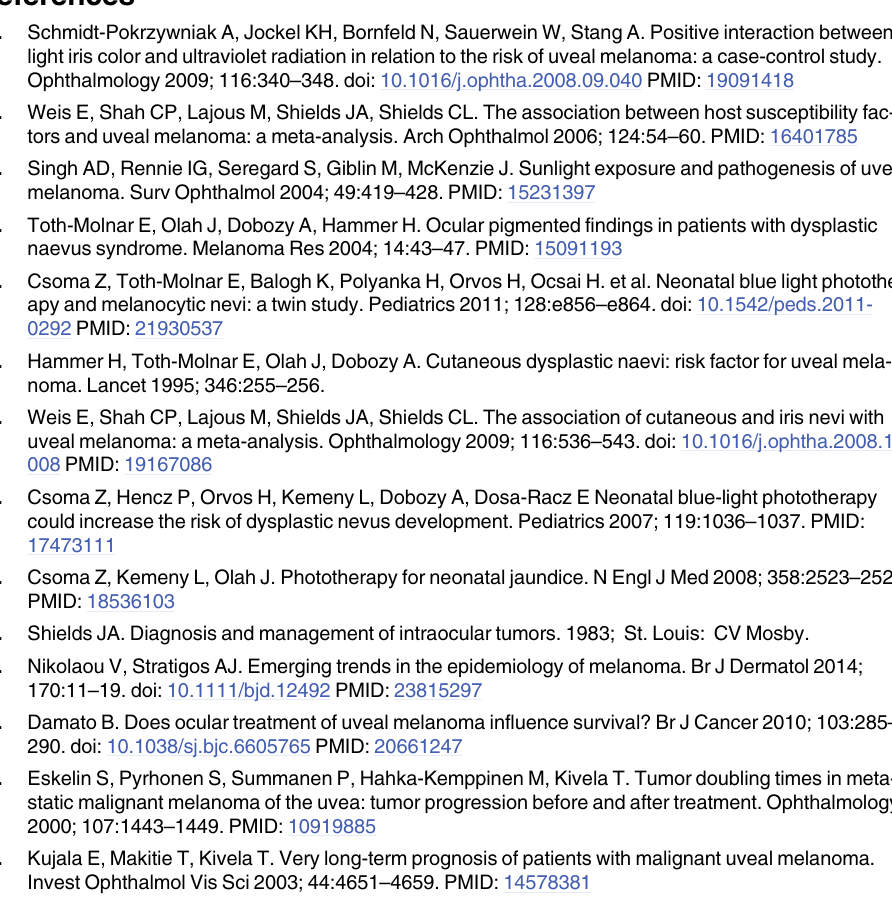
S1 Table. All data from the examined twin pairs can be found in the Supporting Table.